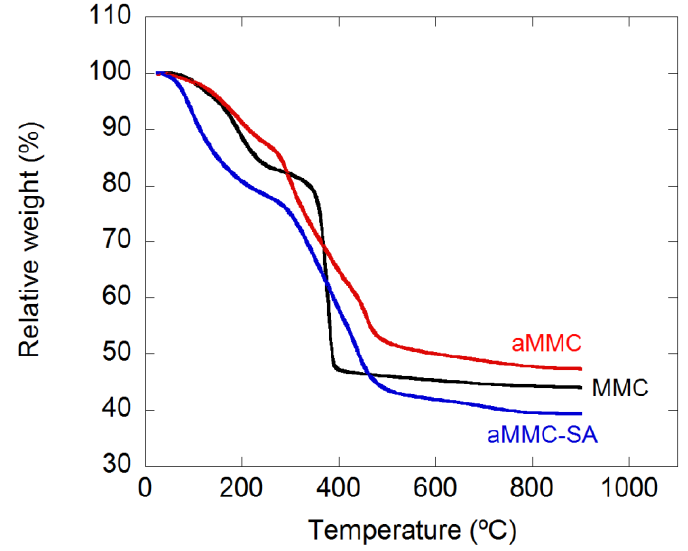
Figure 1. TGA curves for the studied samples.